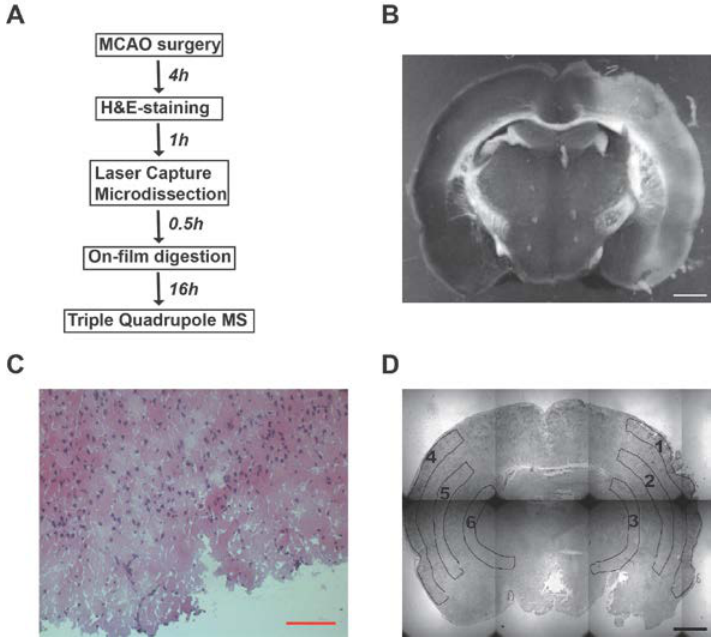
Figure 1. The focal cerebral ischemic model. ( A ) Scheme of sample collection, processing and analysis; ( B ) The extent of cerebral infarct was shown by TTC (2,3,5-triphenyltetrazolium chloride) staining. Scale bar: 1 mm; ( C ) Representative hematoxylin and eosin (H&E)-stained mouse brain sections at 4 h after the occlusion of middle cerebral artery. Scale bar: 100 µm; ( D ) Laser capture microdissection (LCM) of intact and infarcted tissue in the cerebral cortex. Microscopic findings of focal ischemic tissue in the right cerebral cortex and normal tissue in the left cerebral cortex. Coronally cut fresh sections were stained with H&E and shown at a low magnification. Zones 1–3 of ischemic brain tissue supplied by right middle cerebral artery were collected by LCM. The corresponding areas (zones